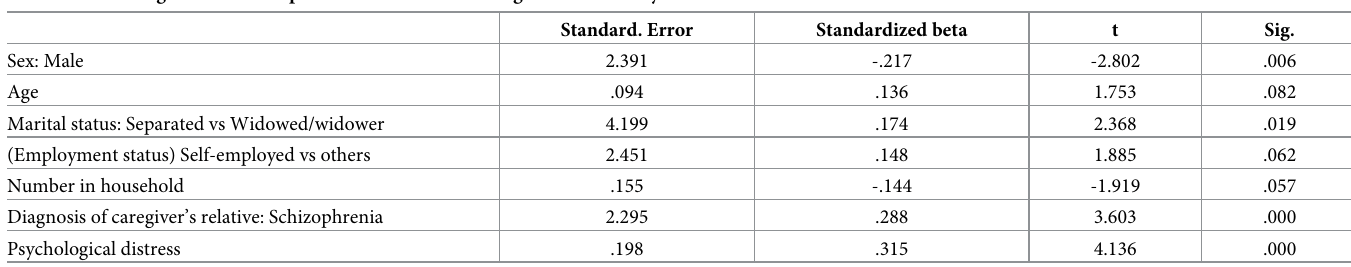
Table 4. Linear regression for the predictors of Burden during care of mentally ill.